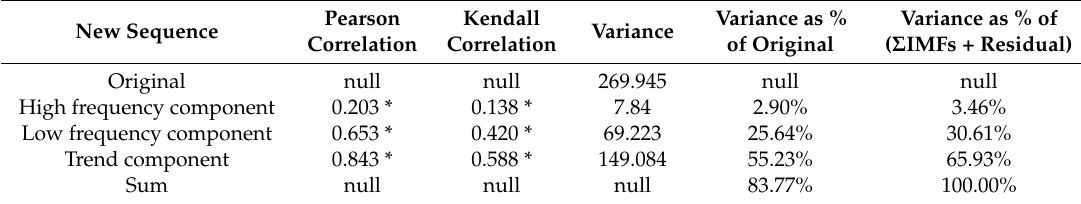
Table 5. Correlations and variances of the